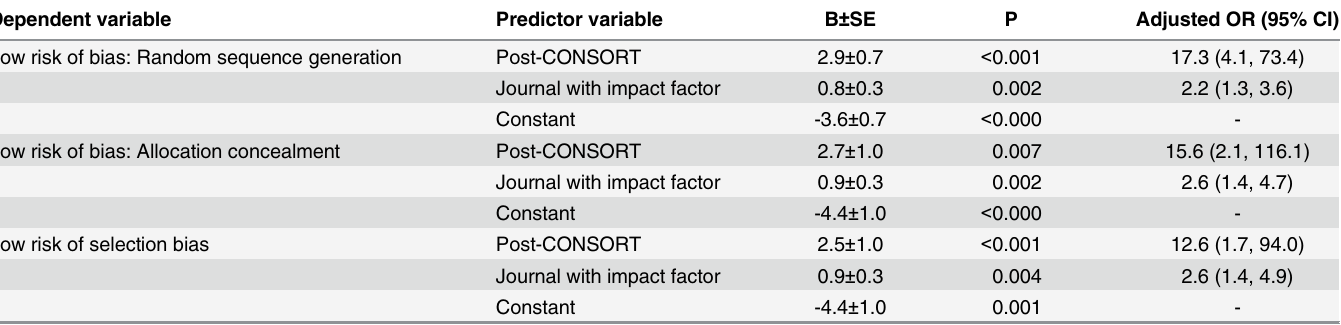
Table 2. Associations of year of publication (post-CONSORT vs. pre-CONSORT) and impact factor (with impact factor vs. without) with risk of selection bias. B, regression coefficient; CI, confidence interval; OR, odds ratio; SE, standard error.